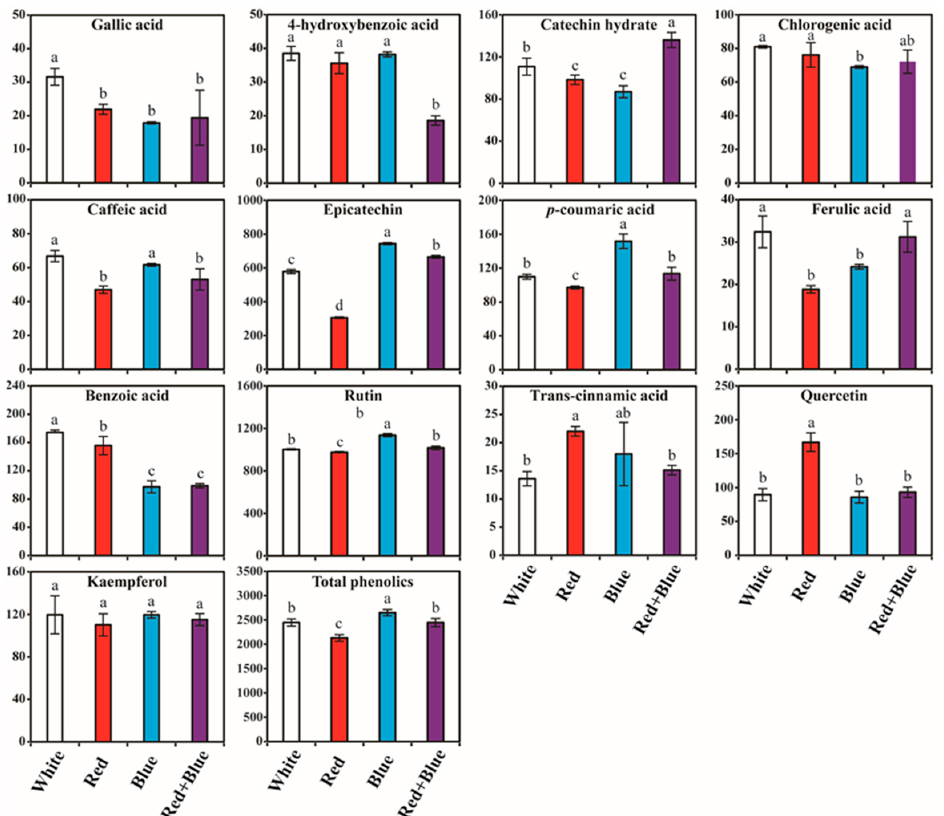
Figure 3. Phenylpropanoid content (µg/g DW) in kohlrabi sprouts irradiated with di ff erent LED lights. Samples were collected after 10 days of growth. Mean values marked with di ff erent alpha- betical le tt ers were signi fi cantly di ff erent ( p < 0.05, ANOVA, DMRT).